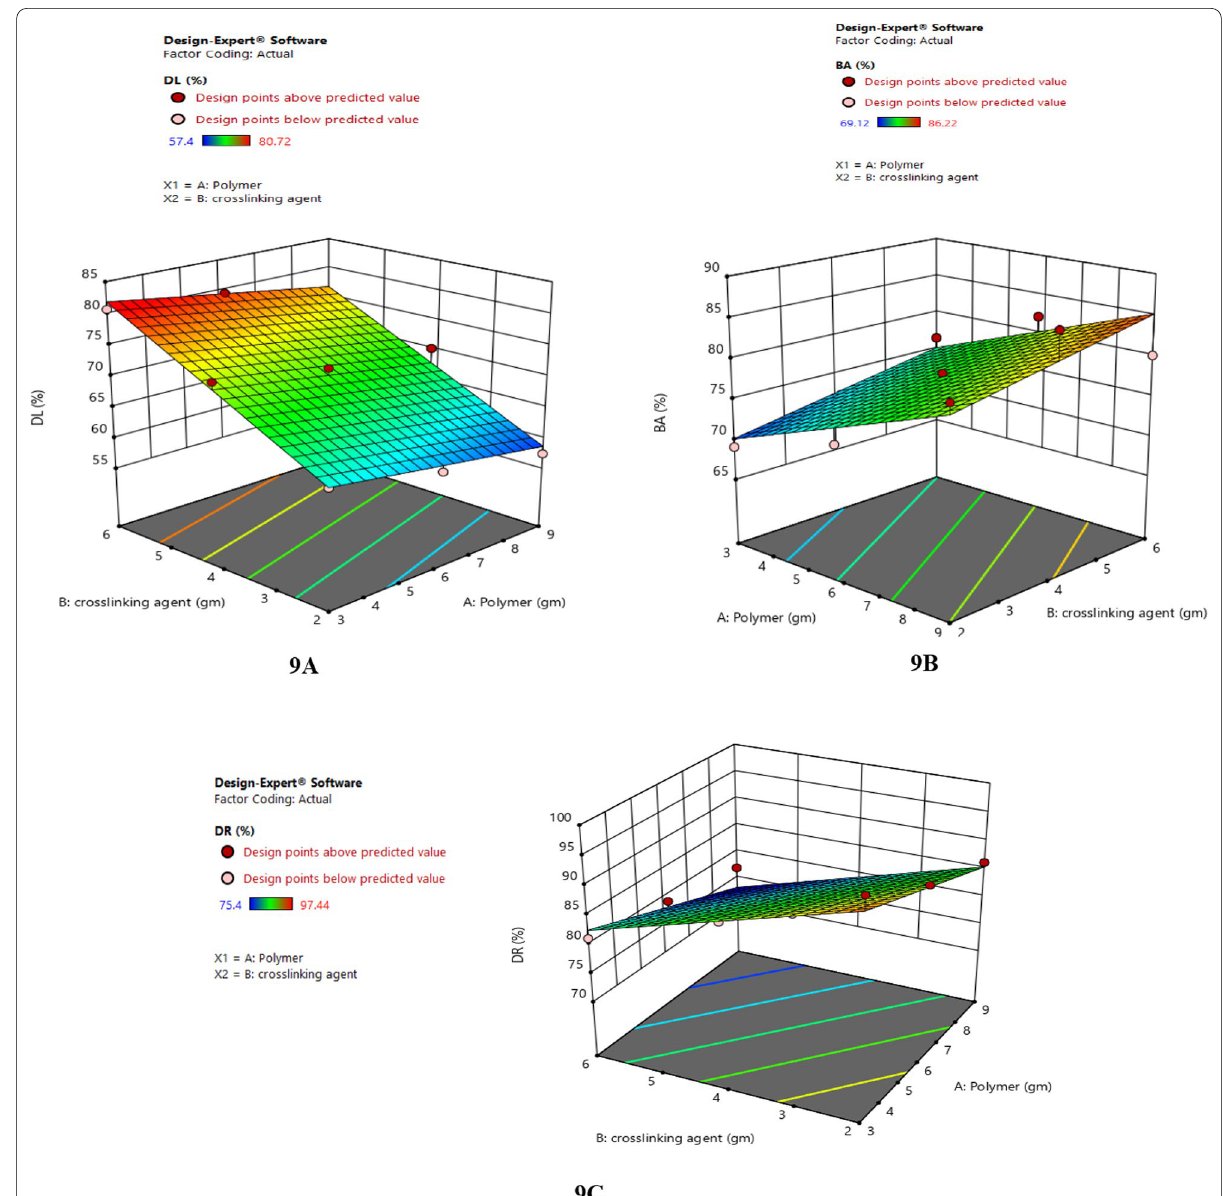
Fig. 9 The 3D plot generated from the design expert software a 3D plot for % drug loading b 3D plot for % bio adhesion c 3D plot for % drug